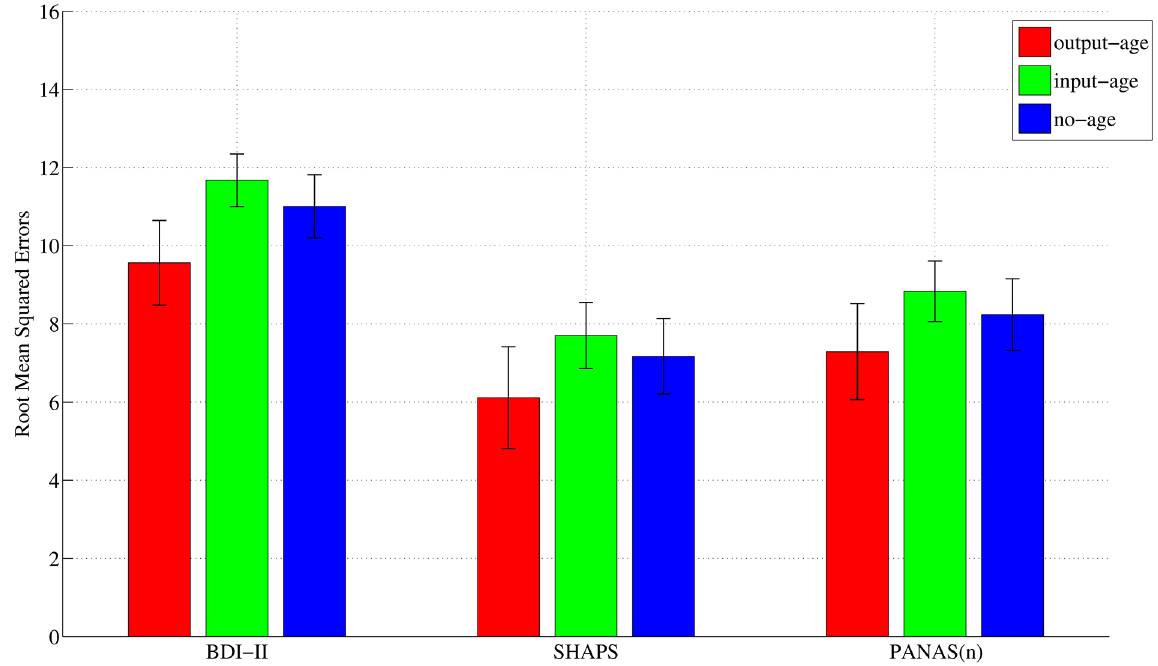
Fig 3. Root mean squared errors in KPLS-Poly(2). KPLS-Poly(2) achievedsignificantly better performance in output-agemodel than in other models.